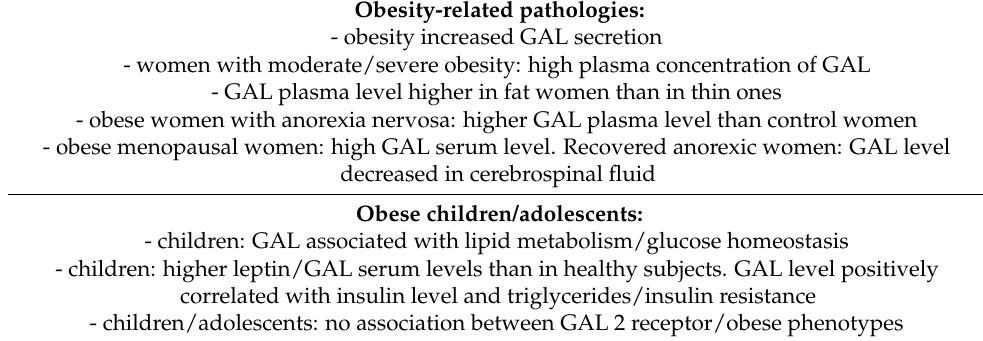
Table 3. Humans: GAL family of peptides and food intake [2,7,33,38,56,83,86,87,89,90]. Obesity-related pathologies: - obesity increased GAL